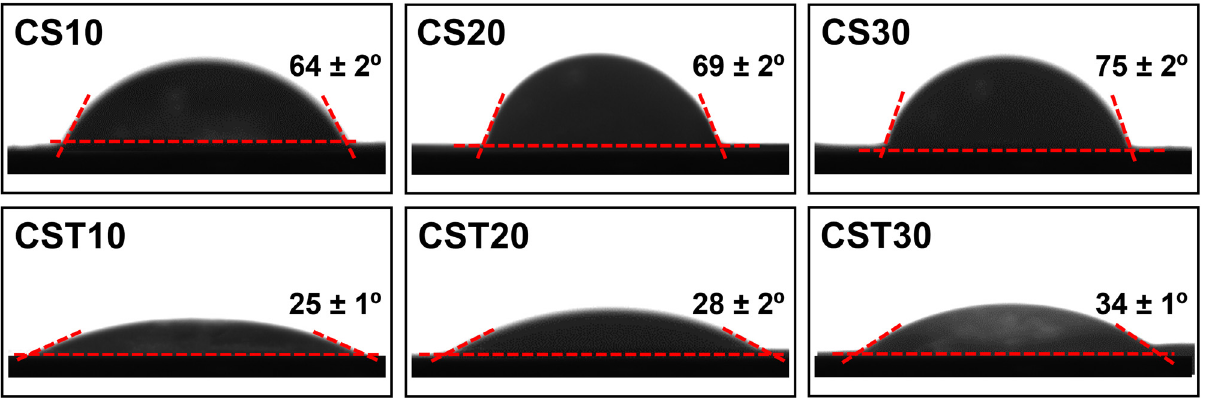
Figure 7: Water contact angles of the nano fi ber mats with and without T80